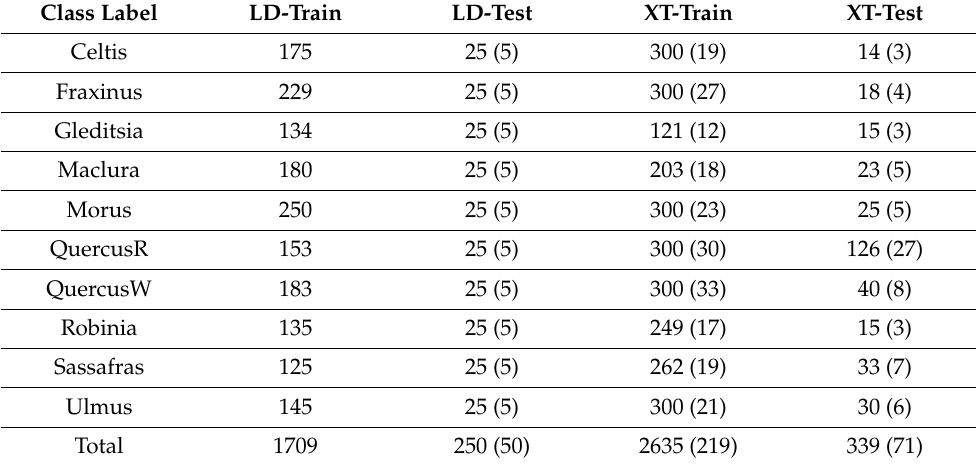
Table 1. Class-wise image counts, including specimen counts (in parentheses) for the four datasets. The number of specimens used in LD-train was not reported in